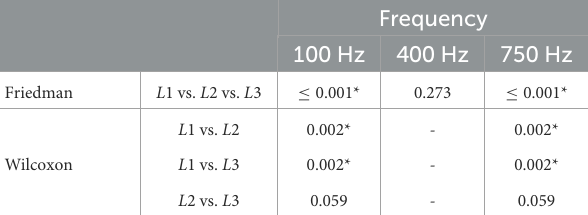
TABLE 2 The p -values of the Friedman for perception threshold comparing the three different physiological sites L1, L2, and L3 at all frequencies is